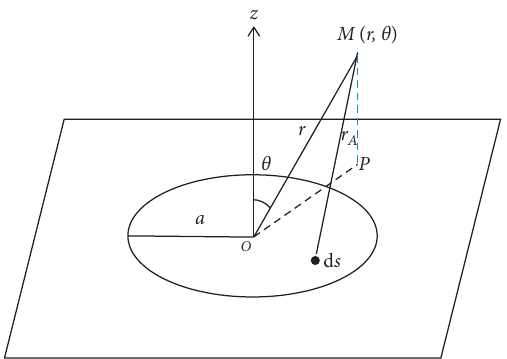
Figure 2: Coordinate frame for a circular knowledge